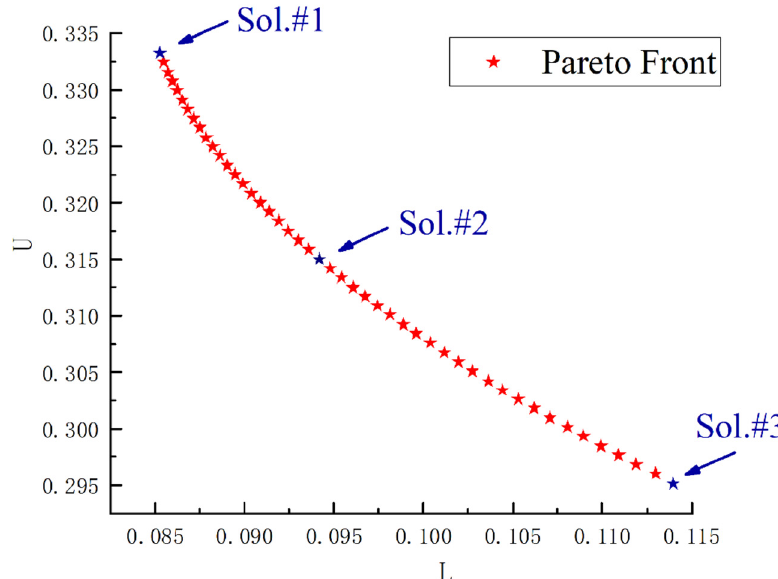
Figure 17. Supercapacitors SOC comparison.